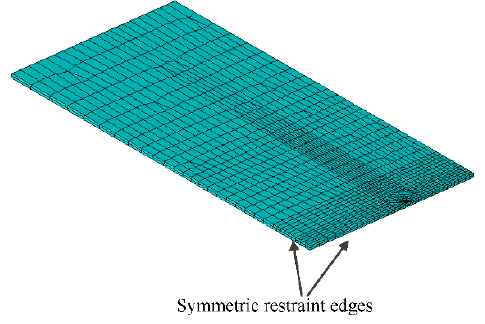
Figure 5. Typical FE model.